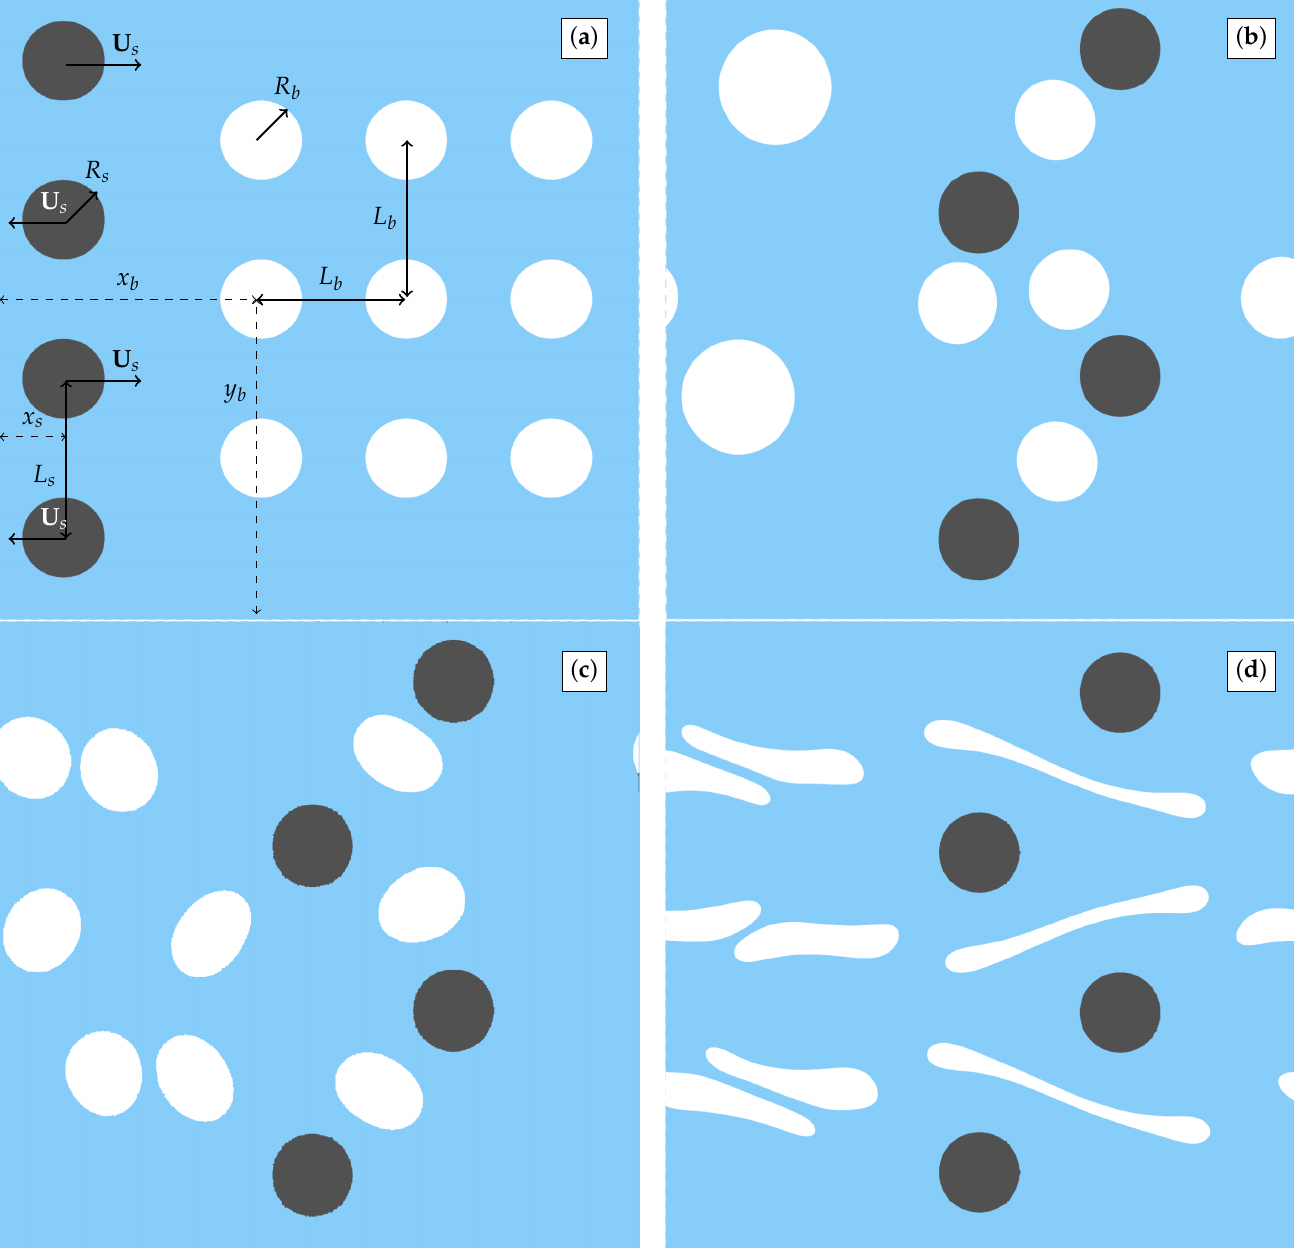
Figure 14. Mixing of a two-fluid medium by moving solids. Dark circles denote solid particles moving along x with a prescribed velocity. White circles indicate droplets of one fluid inside the carrier’s second fluid, which is colored blue. The Reynolds number is Re = 100, and different values of the capillary number are considered. ( a ) Initial condition. The other figures correspond to t = 1.39 and different Ca: ( b ) Ca = 0.01; ( c ) Ca = 0.1; ( d ) Ca = 1. Time t = 1.39 corresponds to two passes of the top solid over the